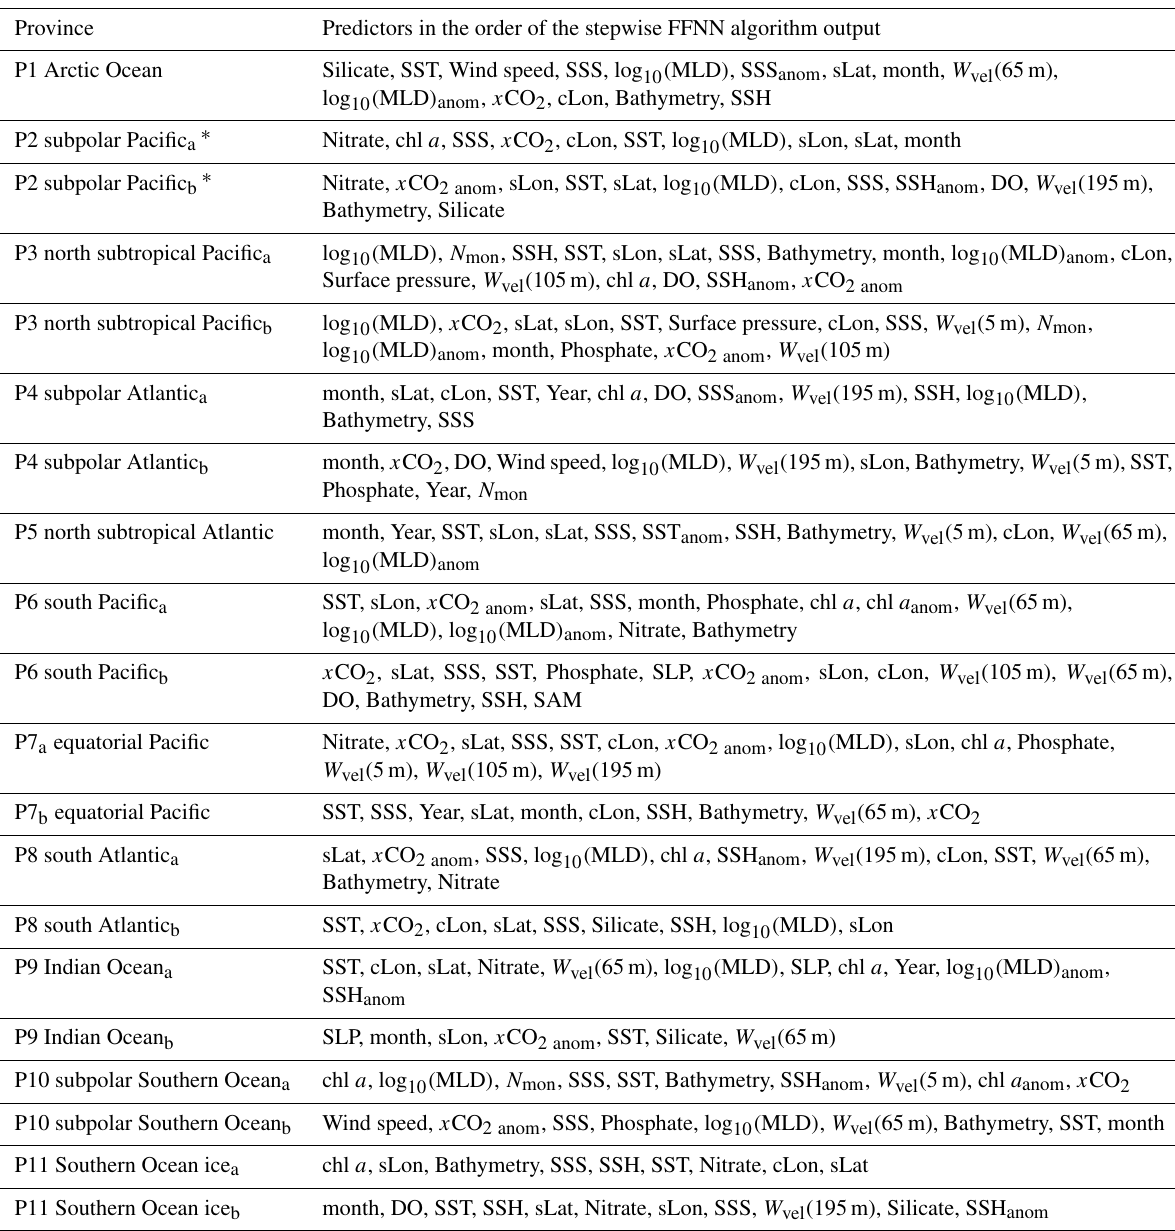
Table 3. Predictors in each biogeochemical province. Province Predictors in the order of the stepwise FFNN algorithm